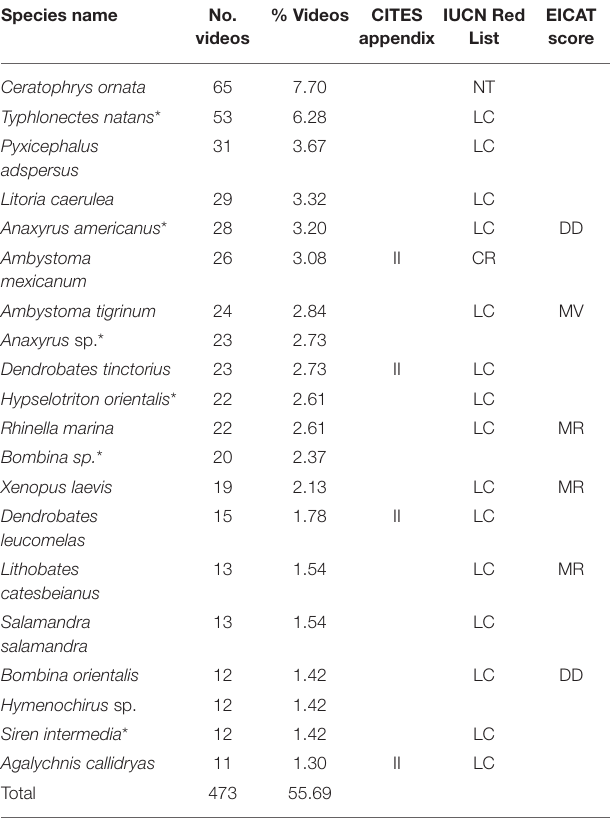
TABLE 1 | The 20 most frequent captive species with videos on YouTube.